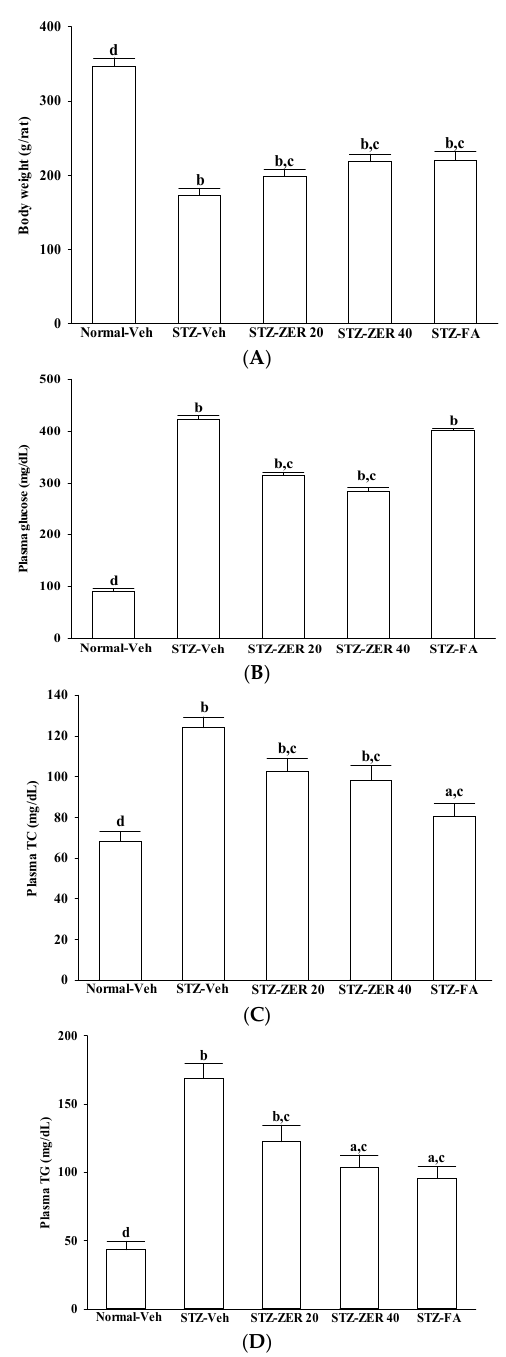
Figure 1. Changes in body weight ( A ) and plasma glucose ( B ), TC ( C ) and TG ( D ) in normal or STZ-diabetic rats receiving three months of treatment. STZ-diabetic rats were administered 20 mg/kg/day zerumbone (STZ-ZER 20), 40 mg/kg/day zerumbone (STZ-ZER 40) or 100 mg/kg fenofibric acid (STZ-FA) by oral gavage once daily for three months. Another group of STZ-diabetic rats (STZ-Veh) and normal rats (Normal-Veh) were administered the same volume of vehicle used to prepare the test medication solutions. Data are mean ± SD from eight rats per group. a p < 0.05 and b p < 0.01 compared to vehicle-treated normal rats, respectively; c p < 0.05 and d p < 0.01 compared to the values of vehicle-treated STZ-diabetic rats, respectively.